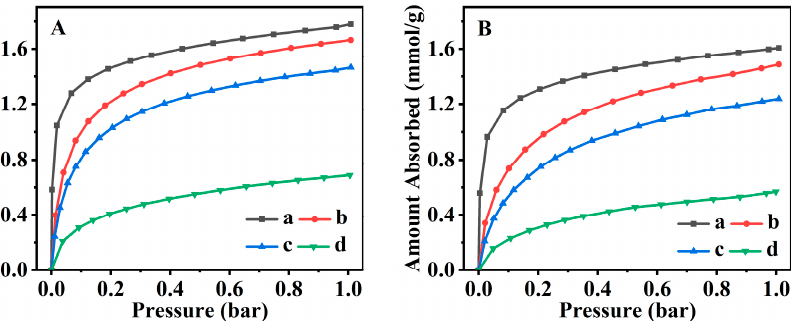
Figure 9. Equilibrium adsorbed isotherms of CO 2 at 273 K ( A ) and 298 K ( B ) for CP (a), Fe(0.03) − H(0.05) − CP − 3 (b), Fe(0.03) − H(0.05) − CP − 9 (c), and Fe(0.03) − H(0.00) − CP − 9 (d).